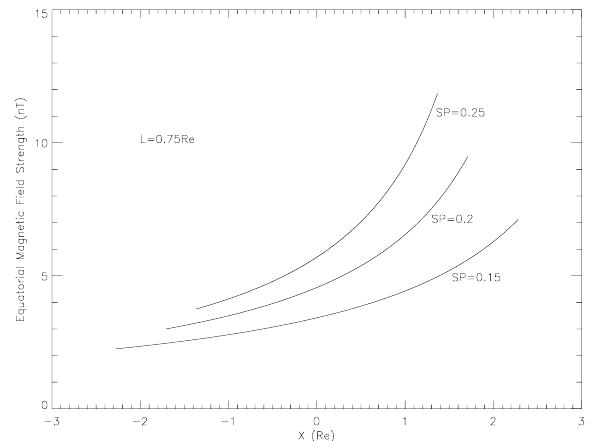
Fig. 4. Growth rate as the function of wave number for each back- ground medium ( L = 0 . 75 R E ). Each labeled line indicates an un- stable domain.